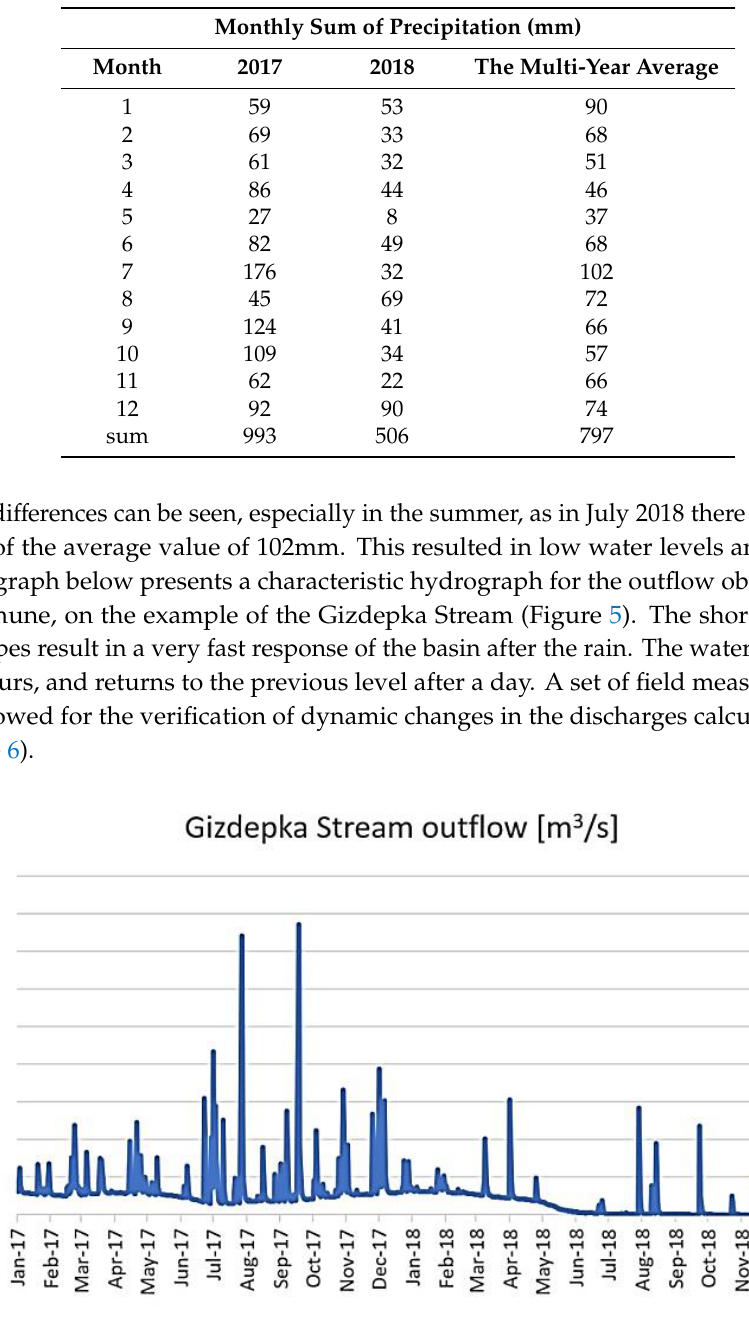
Table 3. Monthly sum of precipitation.